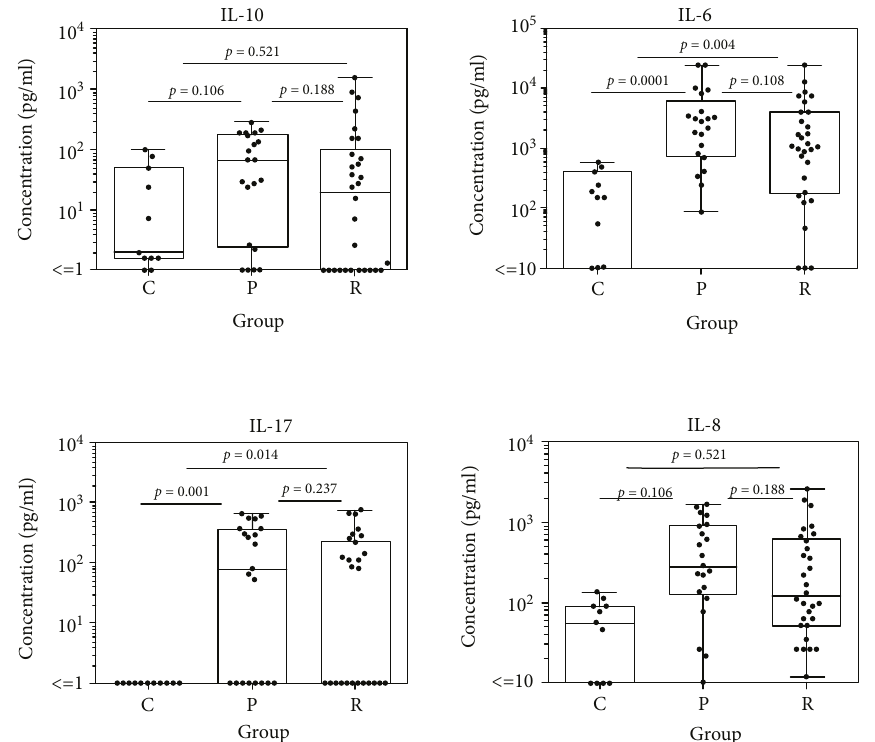
2 cytokine IL-10, the T 17 cell development-promoting cytokine IL-6, the T h h